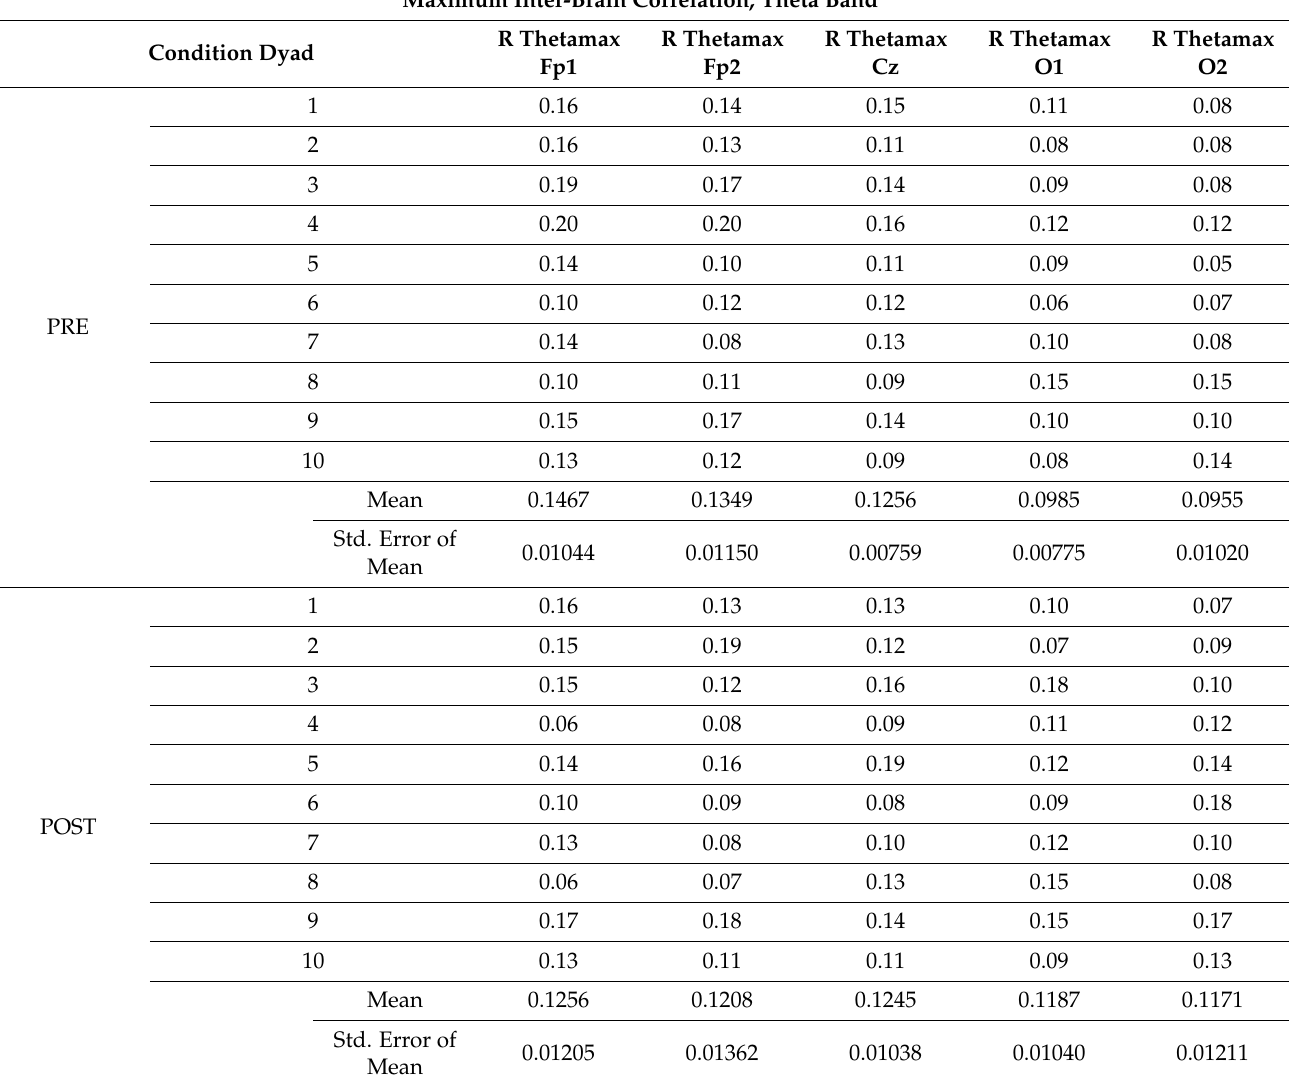
Table A3. Dyad INS summaries data for theta band.